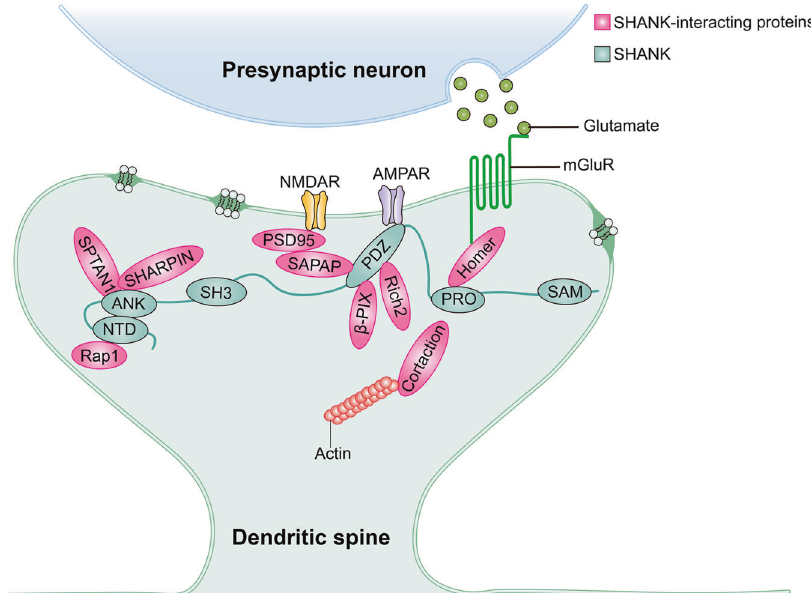
Fig. 3 Schematic diagram of SHANK-interacting proteins at the postsynaptic site. A representation of SHANK located in the PSD is shown, with its protein – protein interaction domains